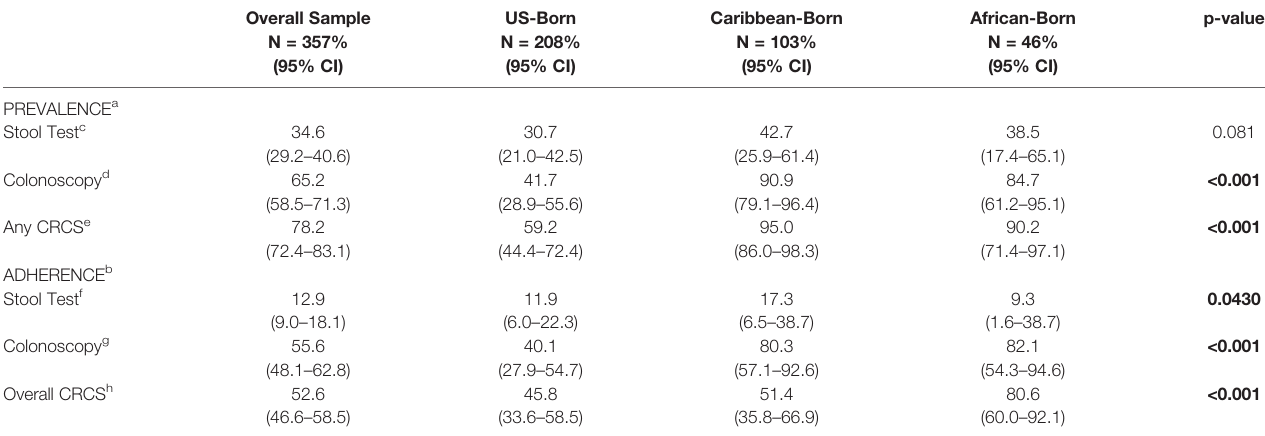
TABLE 2 | Adjusted prevalence and adherence of colorectal cancer screening for the CAP3 study population (N =